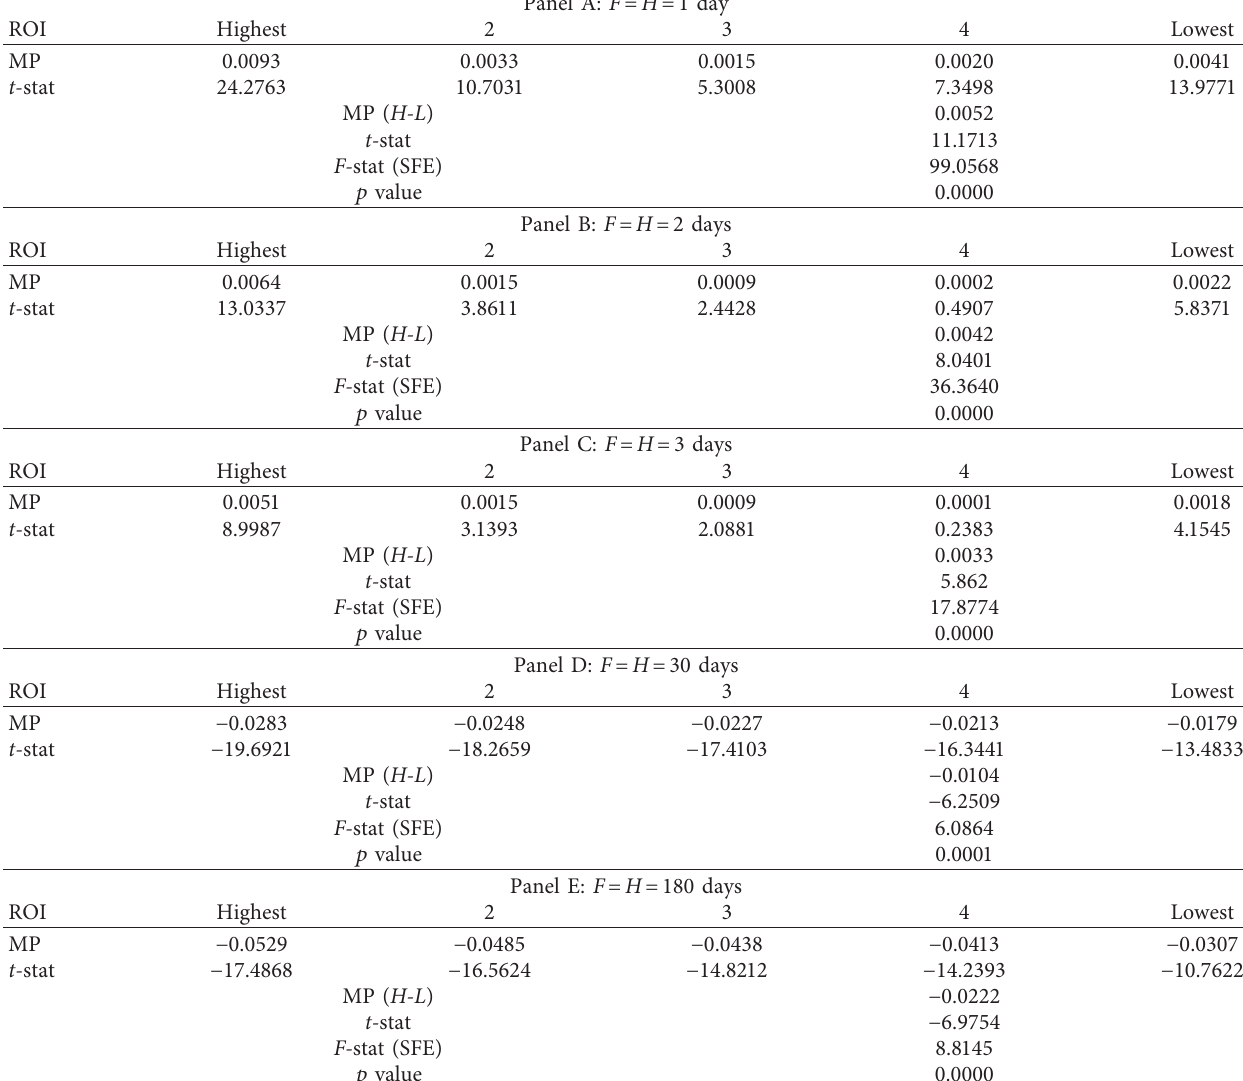
Table 2: The effect of the daily relative order imbalance of the A-share